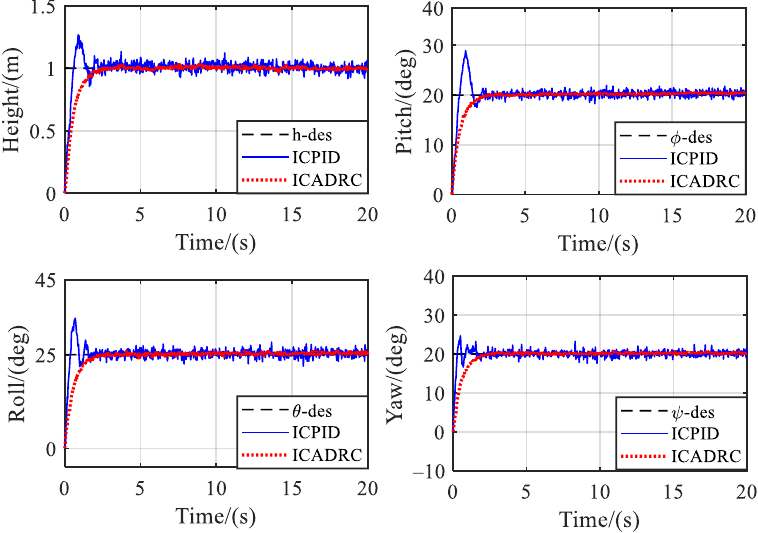
Figure 8. The tracking responses of the quadrotor with disturbance under different controllers.